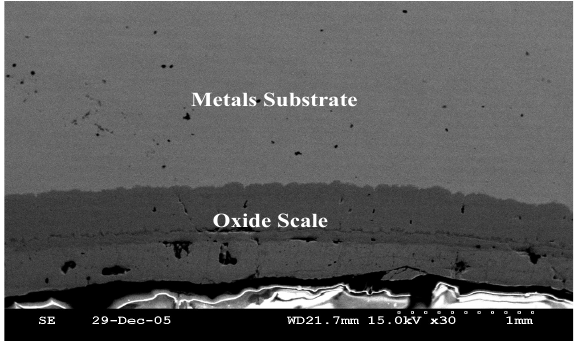
Figure 1. Oxide scales at inner side of superheater